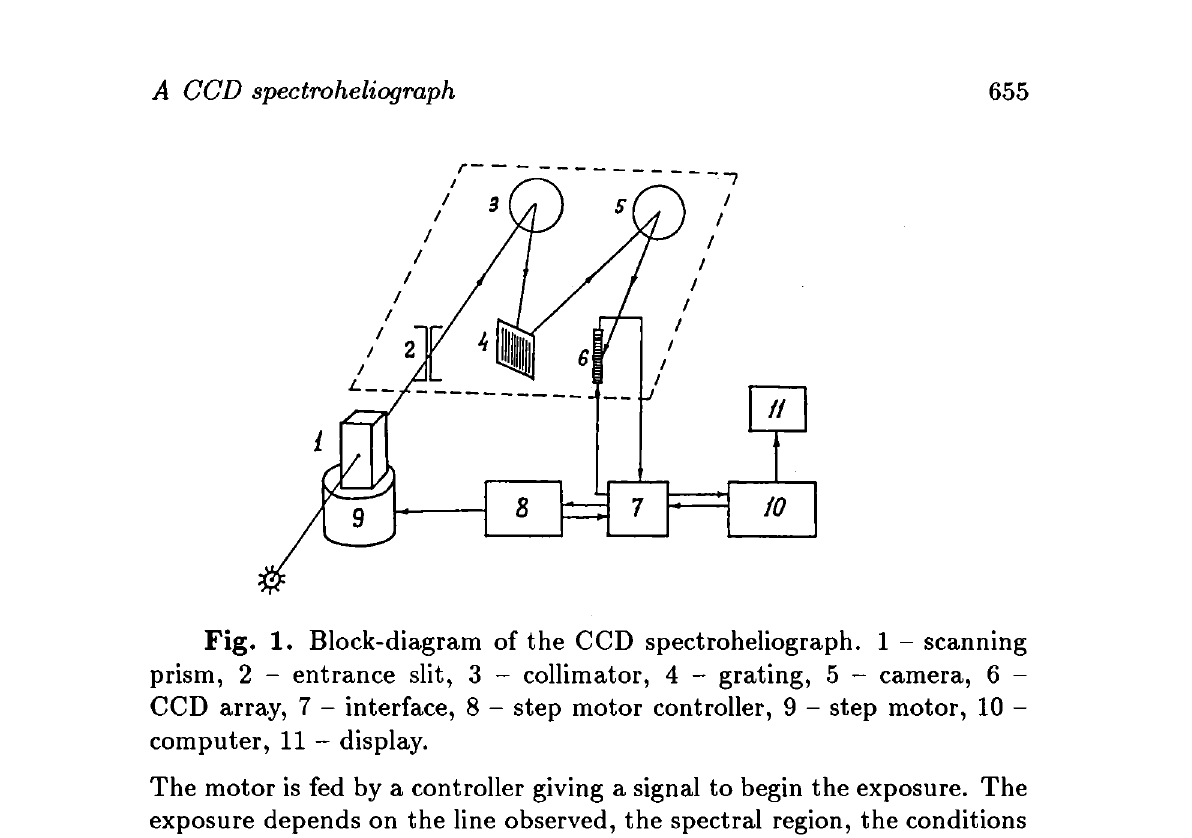
Fig. 1. Block-diagram of the CCD spectroheliograph. 1 - scanning prism, 2 - entrance slit, 3 - collimator, 4 - grating, 5 - camera, 6 - CCD array, 7 - interface, 8 - step motor controller, 9 - step motor, 10 - computer, 11 -